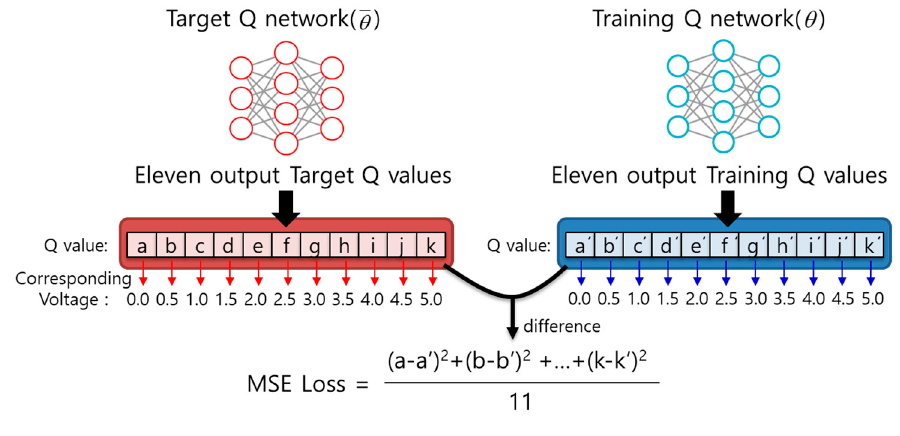
Figure 10. Calculation of MSE loss.